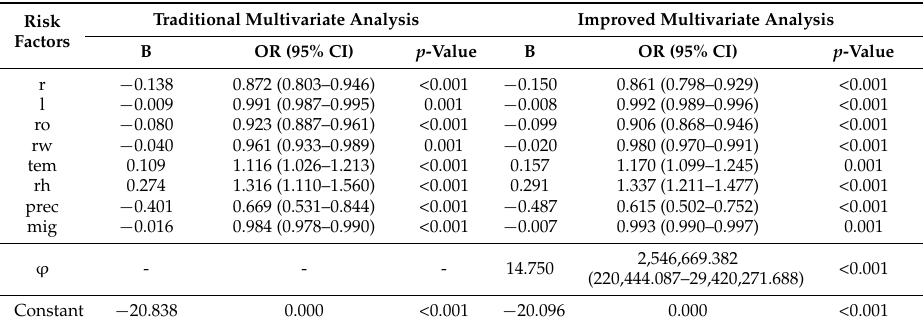
Table 5. Results of multivariate analysis of risk factors for human cases of influenza A(H7N9) virus infection using traditional logistic regression and improved logistic regression, March 2013–December 2014,